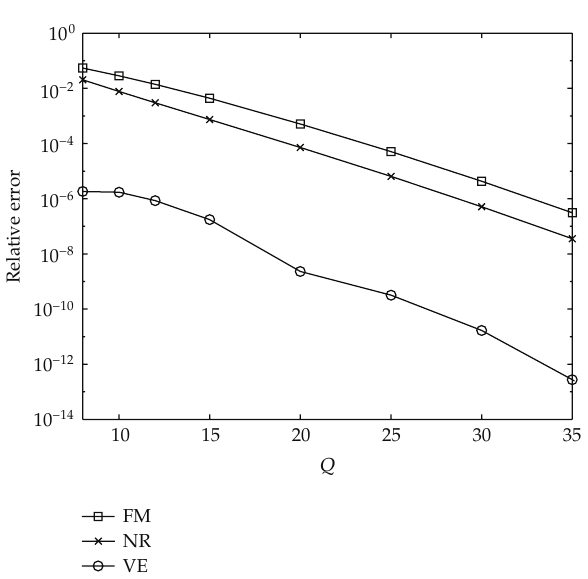
Figure 7: Relative error in N ret for di ff erent techniques.